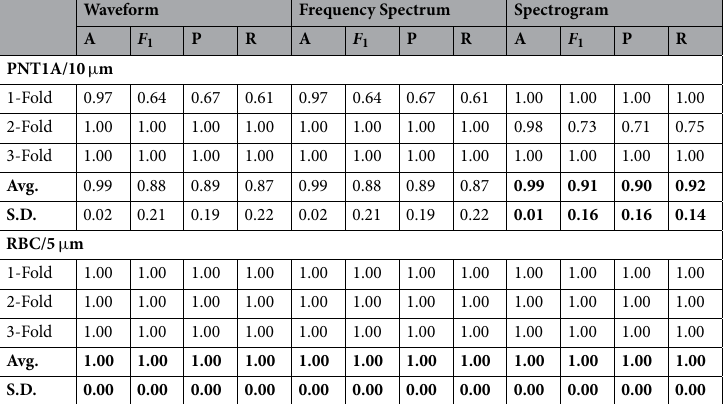
Table 3. Performance of the proposed models for distinguishing cells from similar-sized polystyrene microspheres (i.e., cell-mimicking beads). The upper and lower parts of the table present results between PNT1A ( 10.10 ± 0.88 µ m) and 10 µ m microspheres ( 9.97 ± 0.07 µ m) and results between RBC ( 6.57 ± 0.66 µ m) and 5 µ m microspheres ( 4.98 ± 0.06 µ m), respectively. Significant values are in